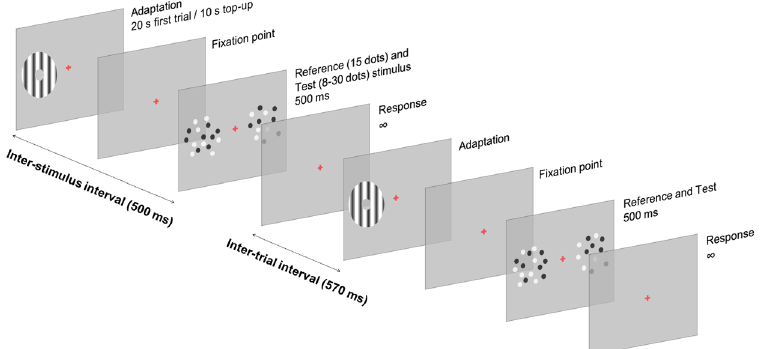
Figure 1. Experimental procedure. Example of the adaptation procedure in the translational motion condition. Each trial started with the presentation of the adaptor stimulus. After the adaptation period, two dot-array stimuli were presented on the screen: a reference (fixed numerosity), presented in the adapted location, and a test (variable numerosity) stimulus presented in a neutral un-adapted location. Participants were asked to discriminate which one of the two dot arrays contained the larger number of dots. After providing a response, the next trial started automatically after a brief blank interval. A similar procedure (except for the kind of adapter stimulus) was applied to investigate the effect of adaptation to circular motion. Stimuli are not reported in scale.